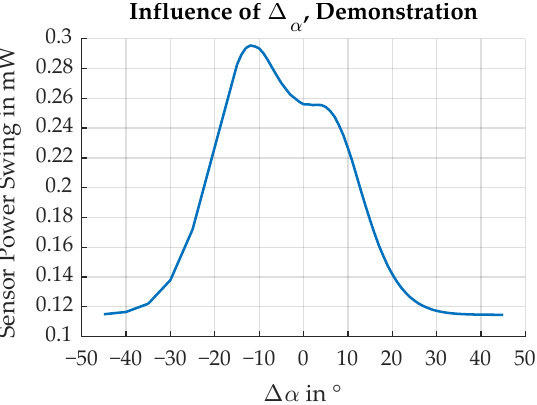
Figure 26. Sensor power swing (maximum value–minimum value) over different emergent angle shifts ∆ α . The maximum swing is at ∆ α = − 12°.